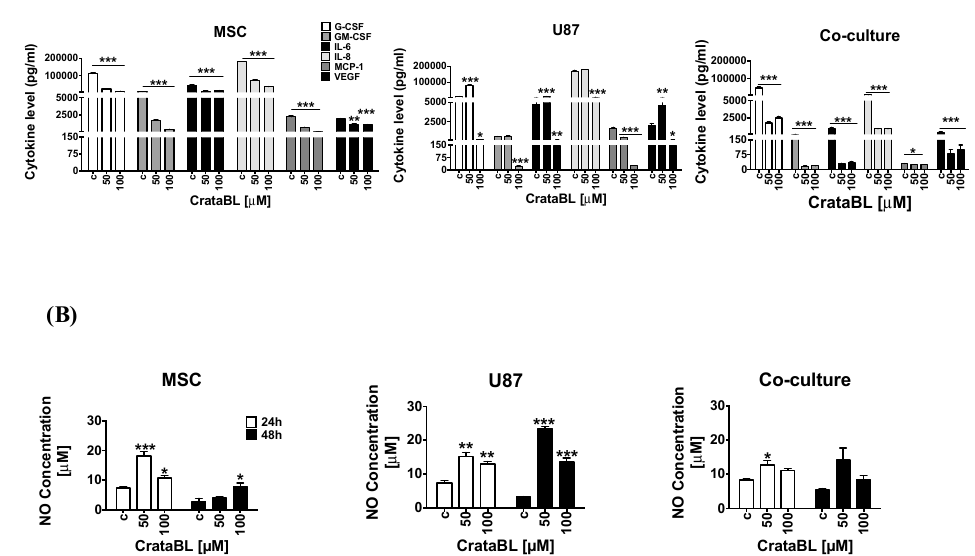
Figure 5. Secreted cytokines profiling and nitric oxide release. Cytokines (G-CSF, GM-CSF, IL-6, IL-8, MCP-1, and VEGF) release following CrataBL treatment with 50 µM and 100 µM after 24 h in the media of ( A ) MSC, U87 glioblastoma cells, and cocultured cells. Nitric oxide release was analyzed by chemiluminescence in ( B ) MSC, U87 glioblastoma cells, and cocultured cells after 24 h and 48 h of CrataBL treatment (50 µM and 100 µM), compared to nontreated controls (c). Significance was considered at * p < 0.05, ** p < 0.005, and *** p < 0.0005 .